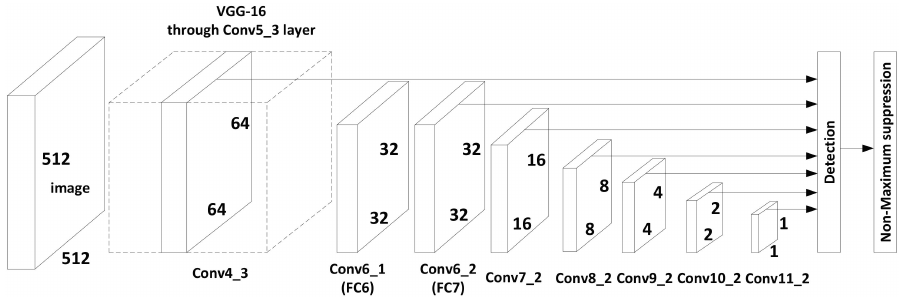
Figure 4. The network architecture. For speeding up training, we do not use MultiBlock and MapBlock in the training